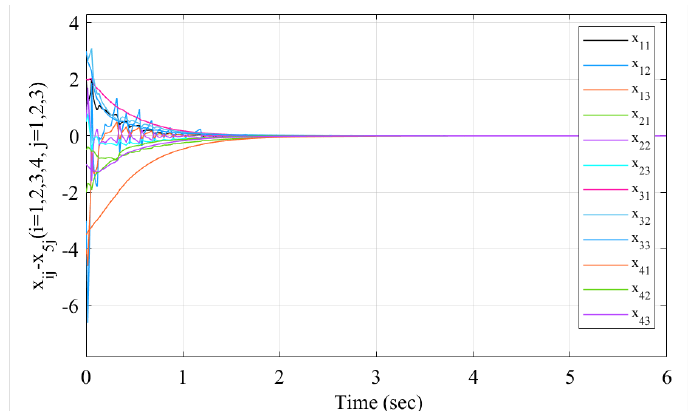
Figure 9. Tracking error trajectories of nodes under DoS